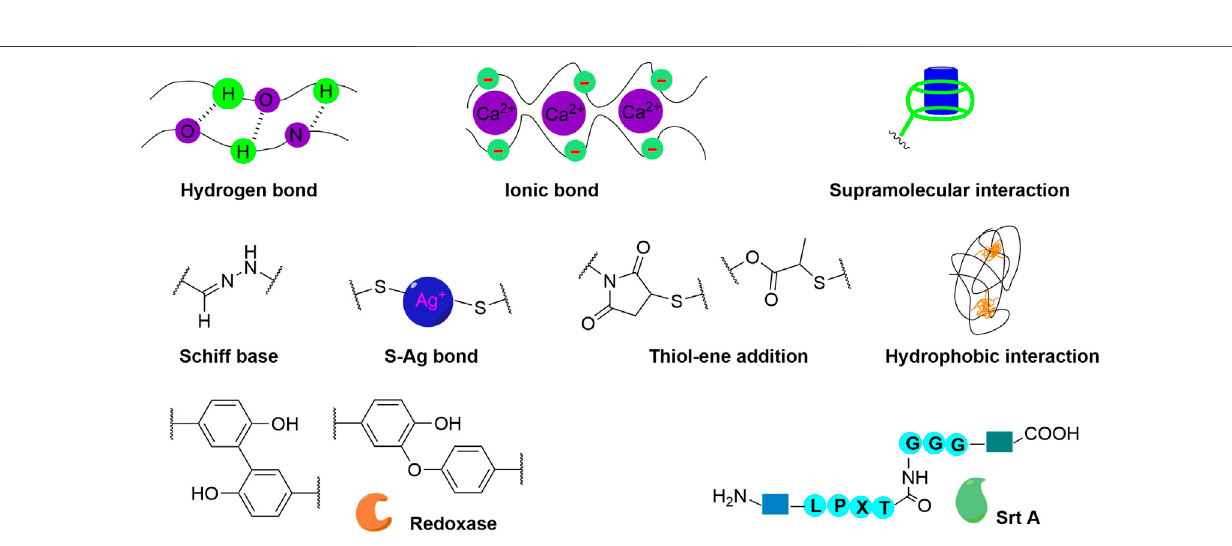
FIGURE 3 | Physical, chemical, and enzymatic crosslinking mechanisms for hydrogel